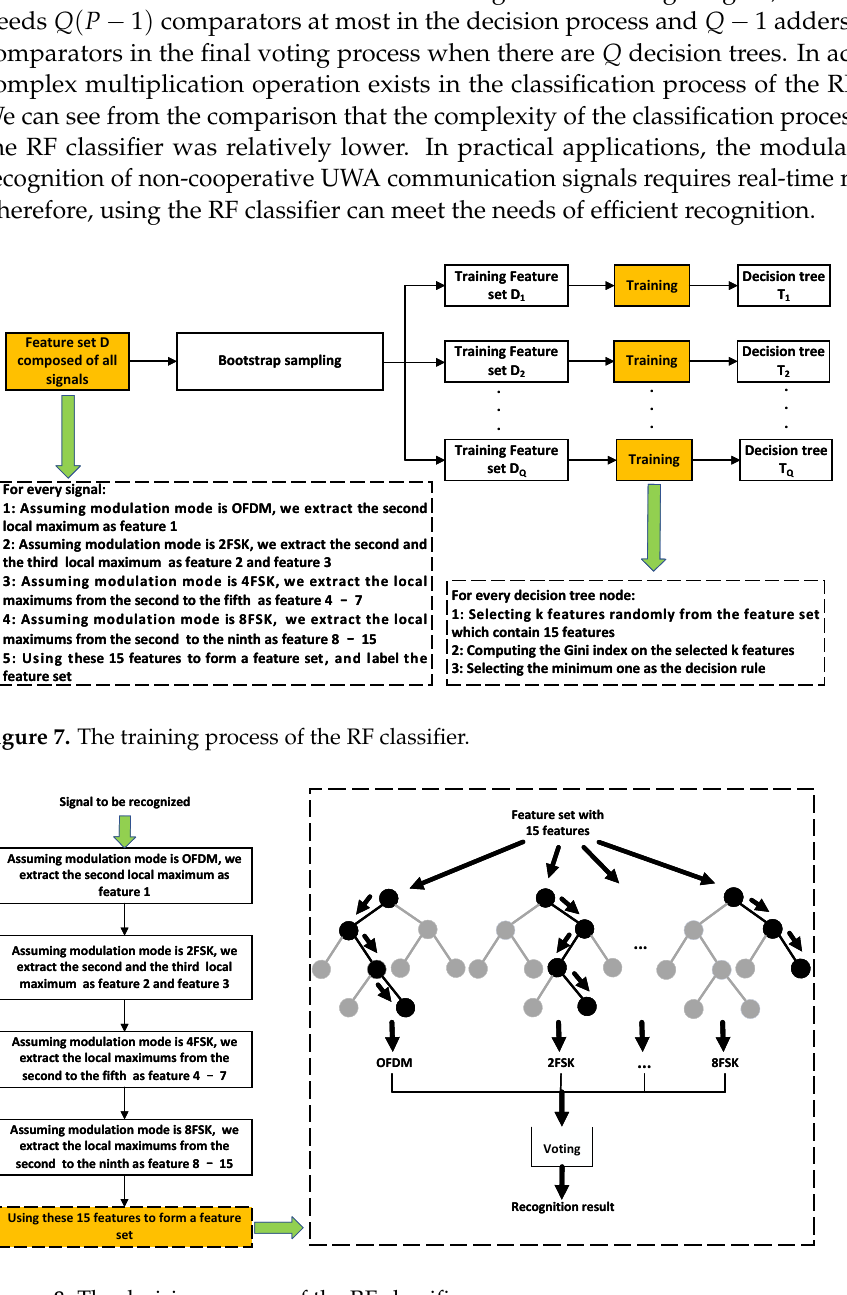
Figure 8. The decision process of the RF